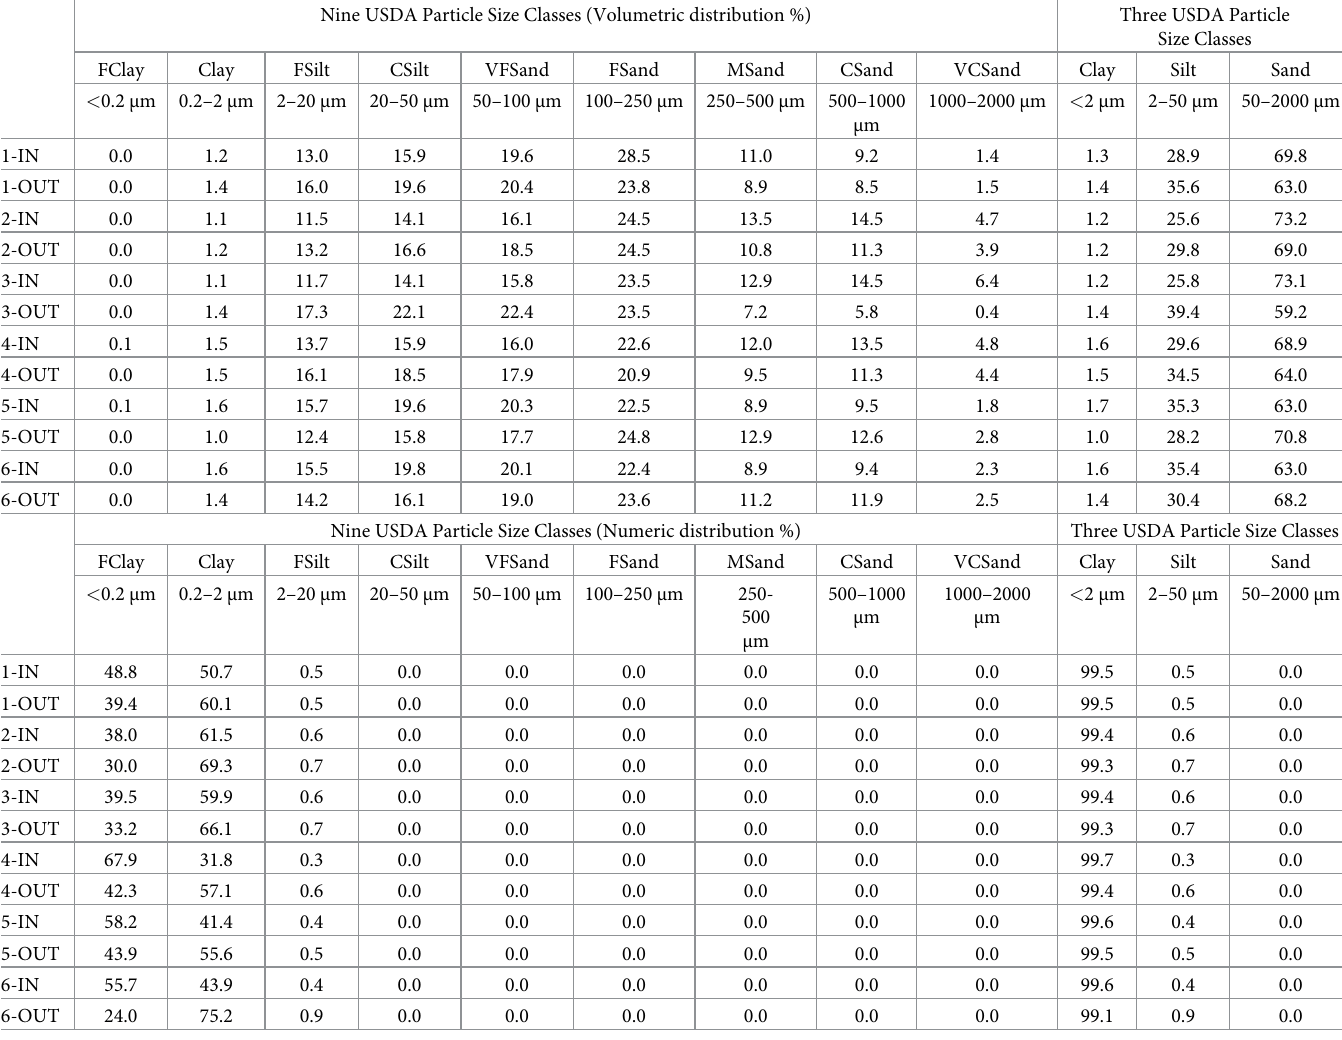
Table 5. Particle size classes based on USDA taxonomy displayed on both a volumetric and numeric basis. Nine USDA Particle Size Classes (Volumetric distribution